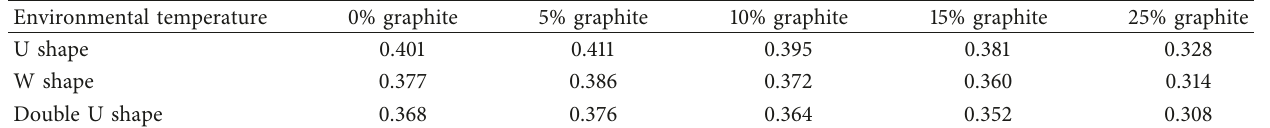
Table 4: Total thermal resistance for different pipe configurations (mKW